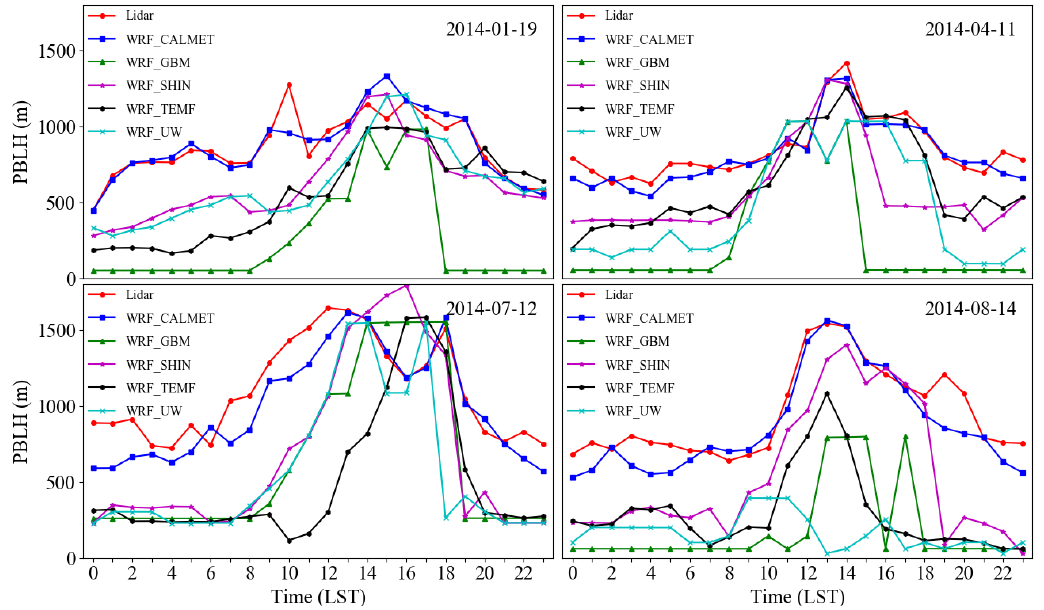
Figure 8. The evaluation of simulated diurnal variation of PBLH from four WRF PBL schemes and WRF/CALMET with the observation from ground-based